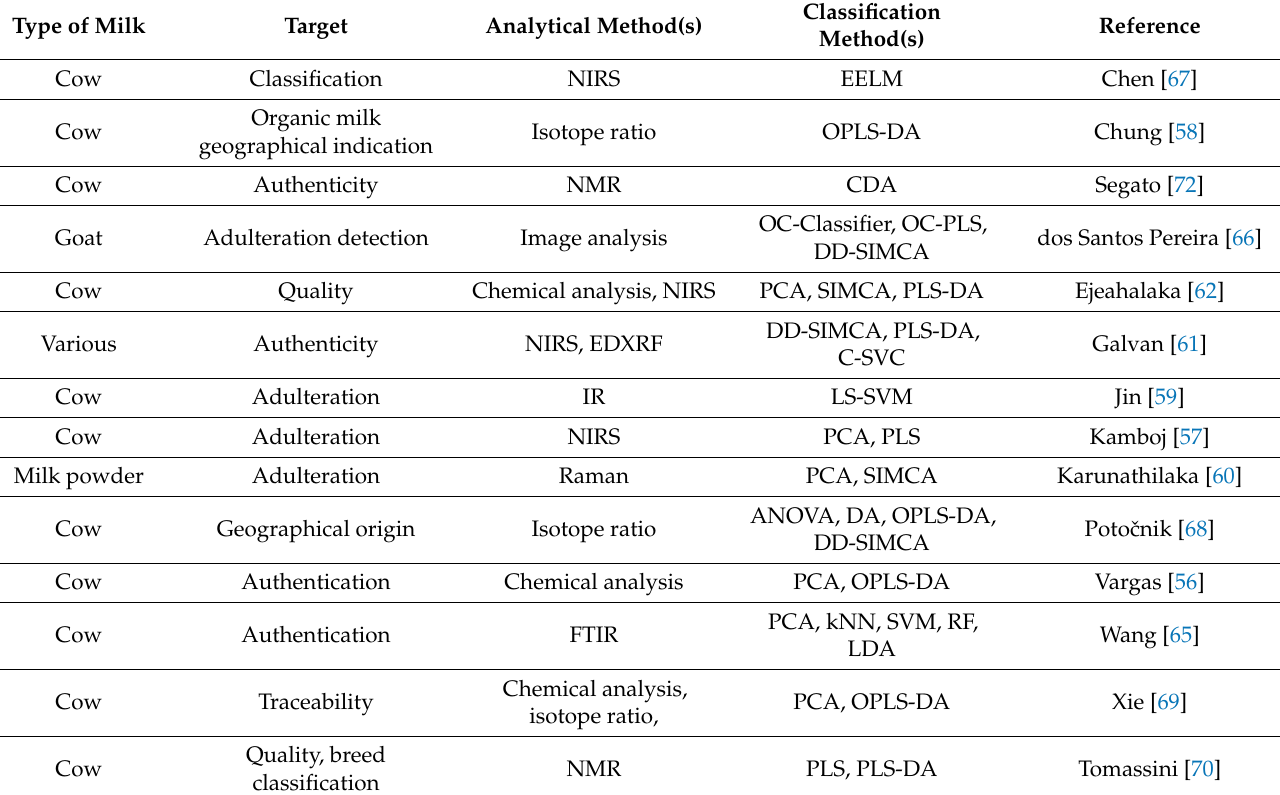
Table 3. Recent studies (since 2018) involving classification methods related to milk